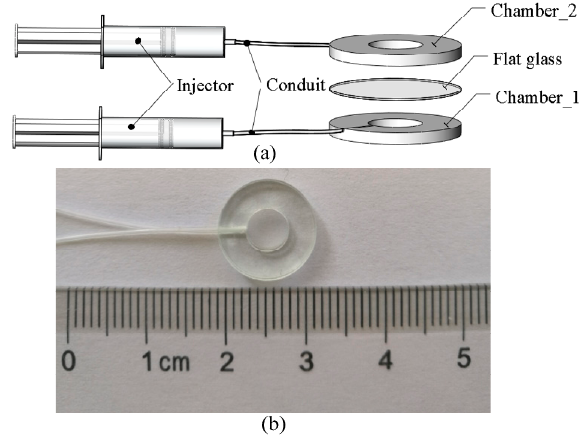
Figure 8. ( a ) Schematic showing the UTL construction. ( b ) Photograph of the UTL.